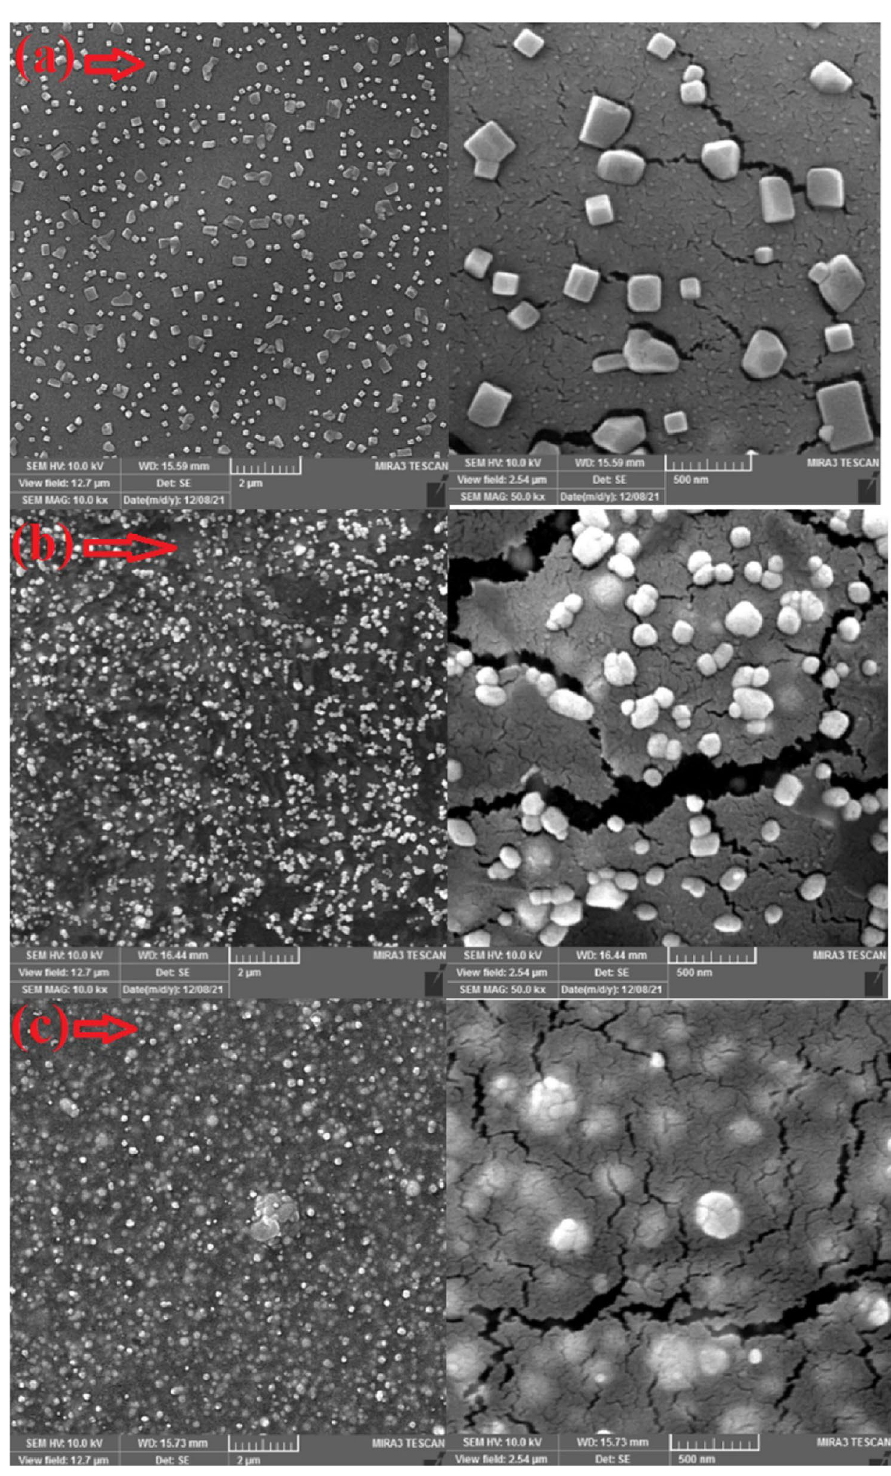
Figure 3. FE-SEM images of ( a ) pure, ( b ) Ag doped, ( c ) Sn doped PbS/PVA and their corresponding high- resolution FE-SEM